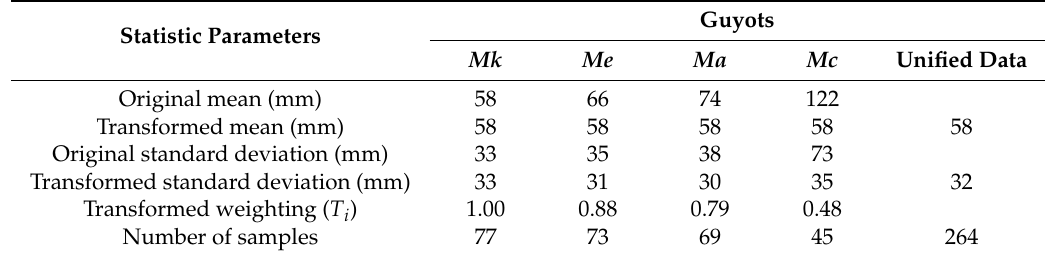
Table 1. Original and unified parameters of the cobalt-rich crust thickness of the four selected guyots. Guyots Statistic Parameters Mk Me Ma Mc Unified Data Original mean (mm) 58 66 Transformed mean (mm)